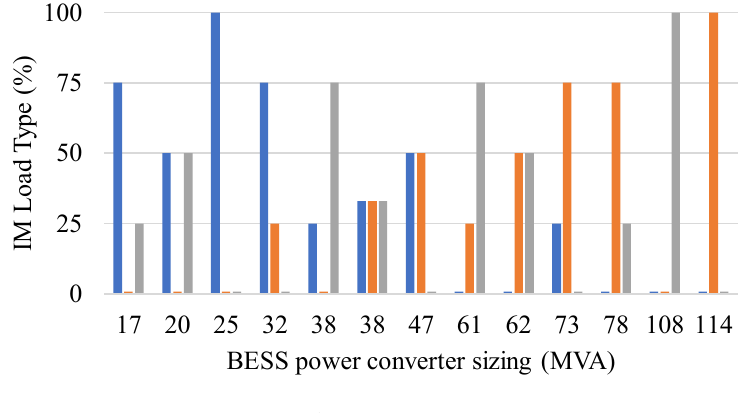
Figure 14. Grid-forming BESS power converter sizing vs. IM load composition (Ref: refrigerator type; SIM: small industrial motor type; LIM: large industrial motor type).